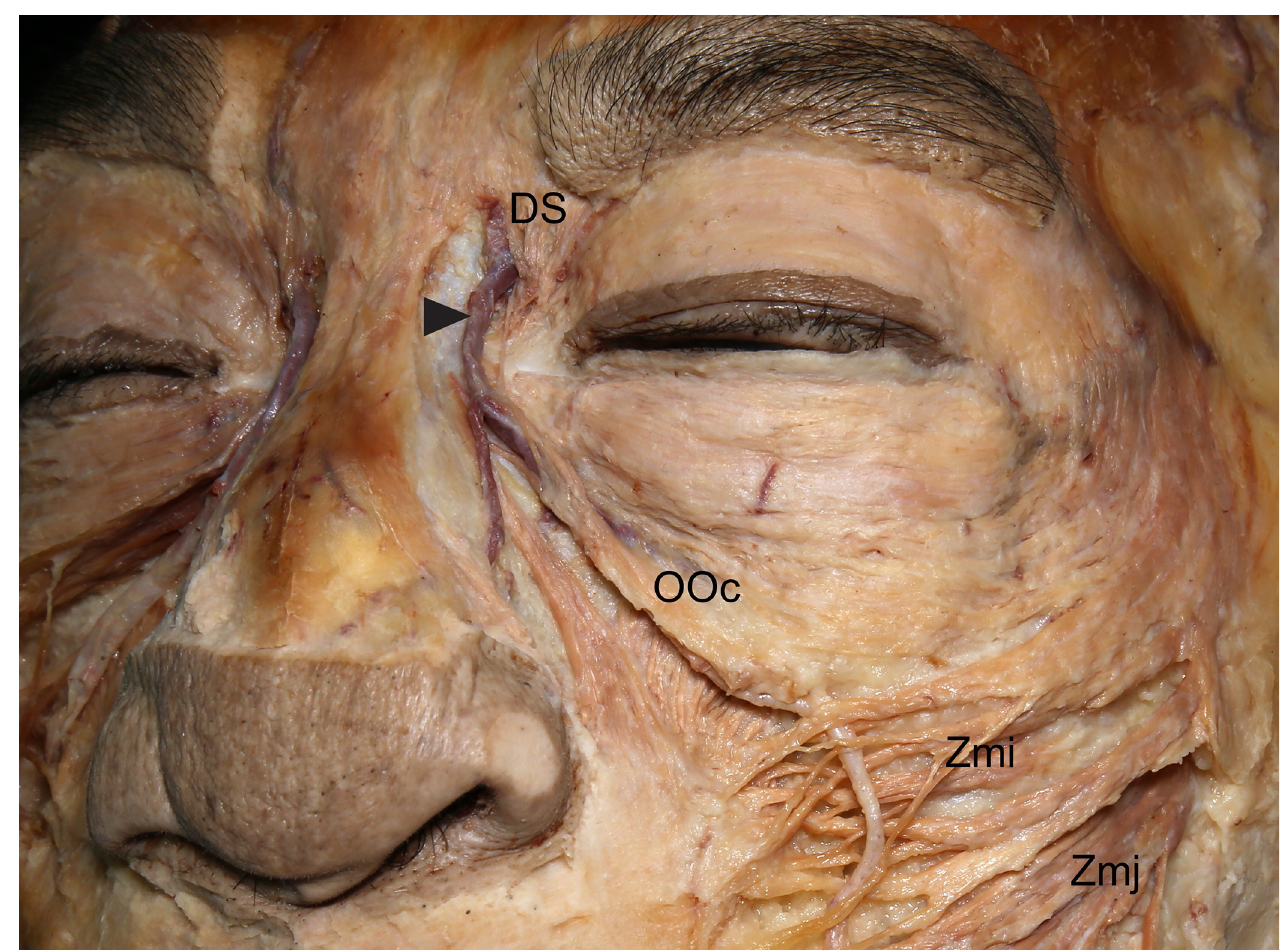
Fig 1. Course of the angular vein (arrowhead) in relation to the depressor supercilii (DS) in the upper face. The angular vein passed through the DS fibers and descended to the medial palpebral ligament. OOc, orbicularis oculi; Zmi, zygomaticus minor; Zmj, zygomaticus major.